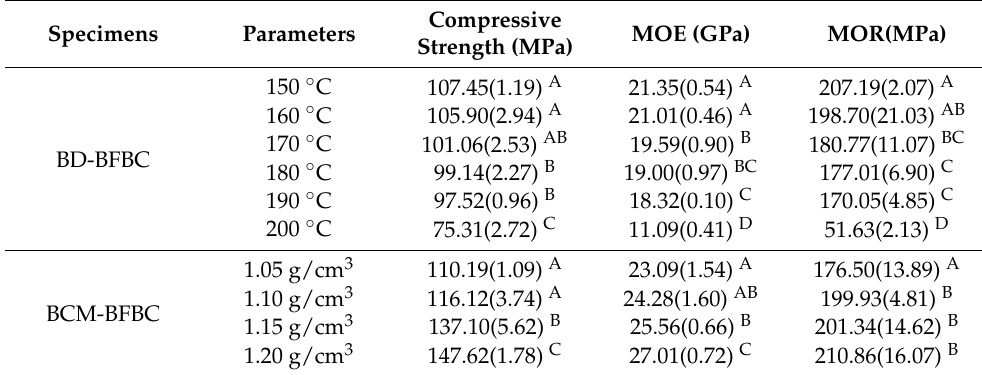
Table 2. Mechanical properties of BD-BFBC produced at different hot press